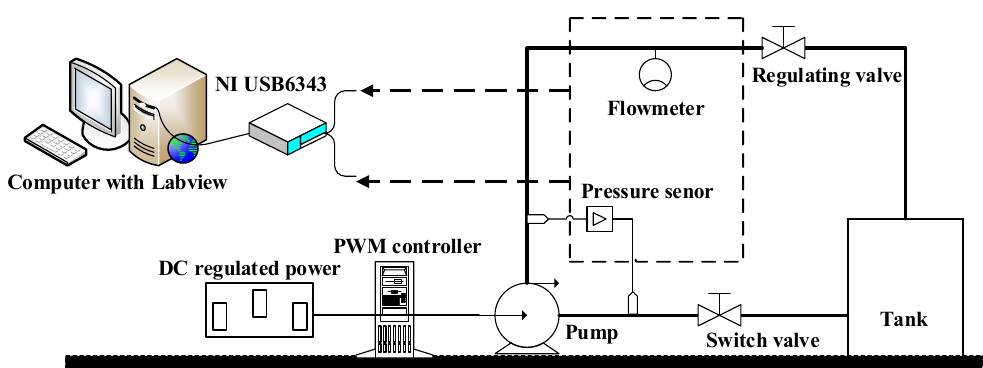
Figure 6. The schematic diagram of test rig.